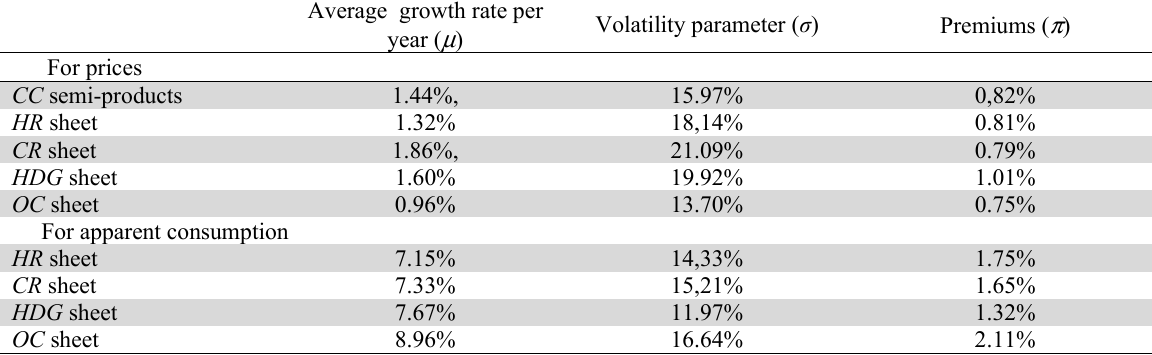
The average growth rate per year ( μ ), volatility parameter ( σ ) and the premiums ( π )